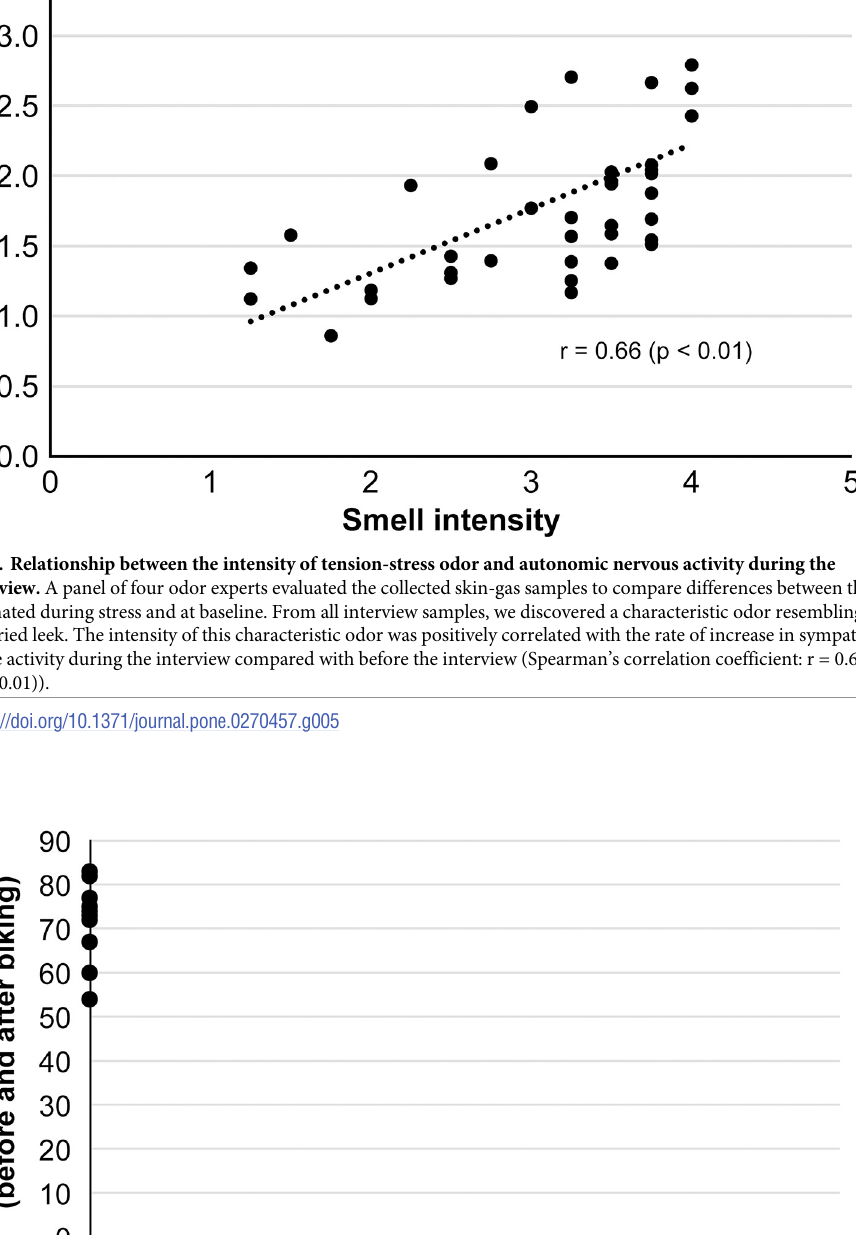
PLOS ONE | https://doi.org/10.1371/journal.pone.0270457 June 30,